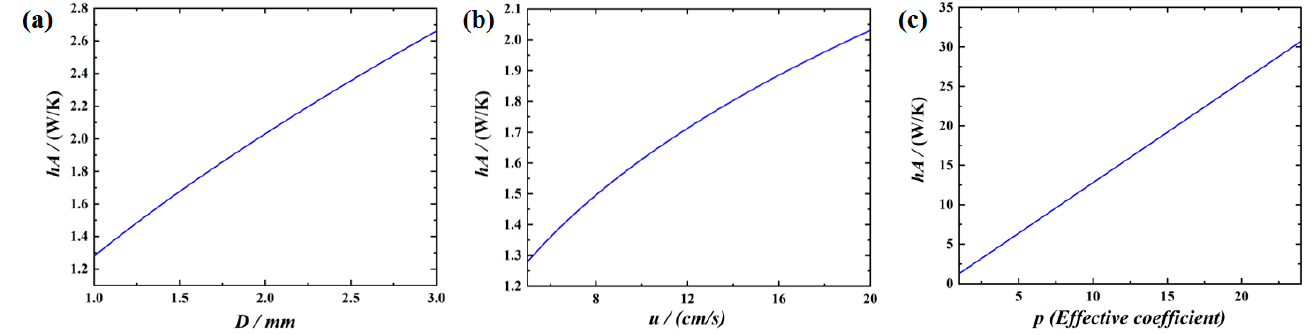
Figure 3. Effects of ( a ) diameter; ( b ) fluid rate of the liquid; ( c ) effective coefficient on hA .